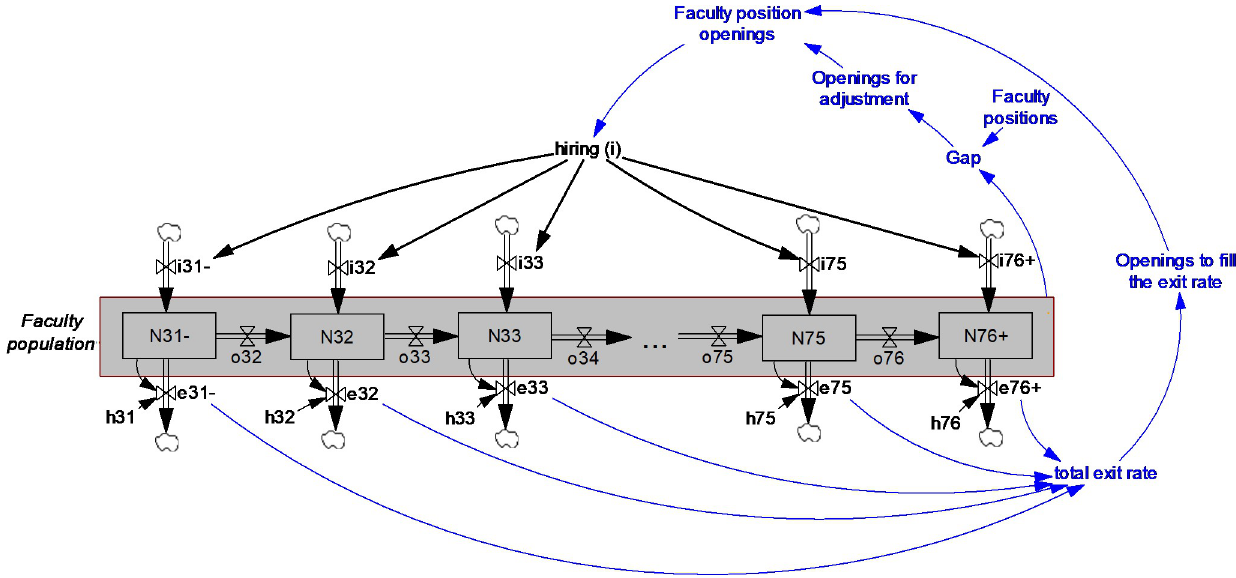
Fig 1. A simple representation of a stock-flow model of faculty members. Note: the value for faculty positions is not necessarily constant; numbers depict age; N: population; i: hiring inflow; e: exit rate; o: aging; h: hazard rate of attrition.